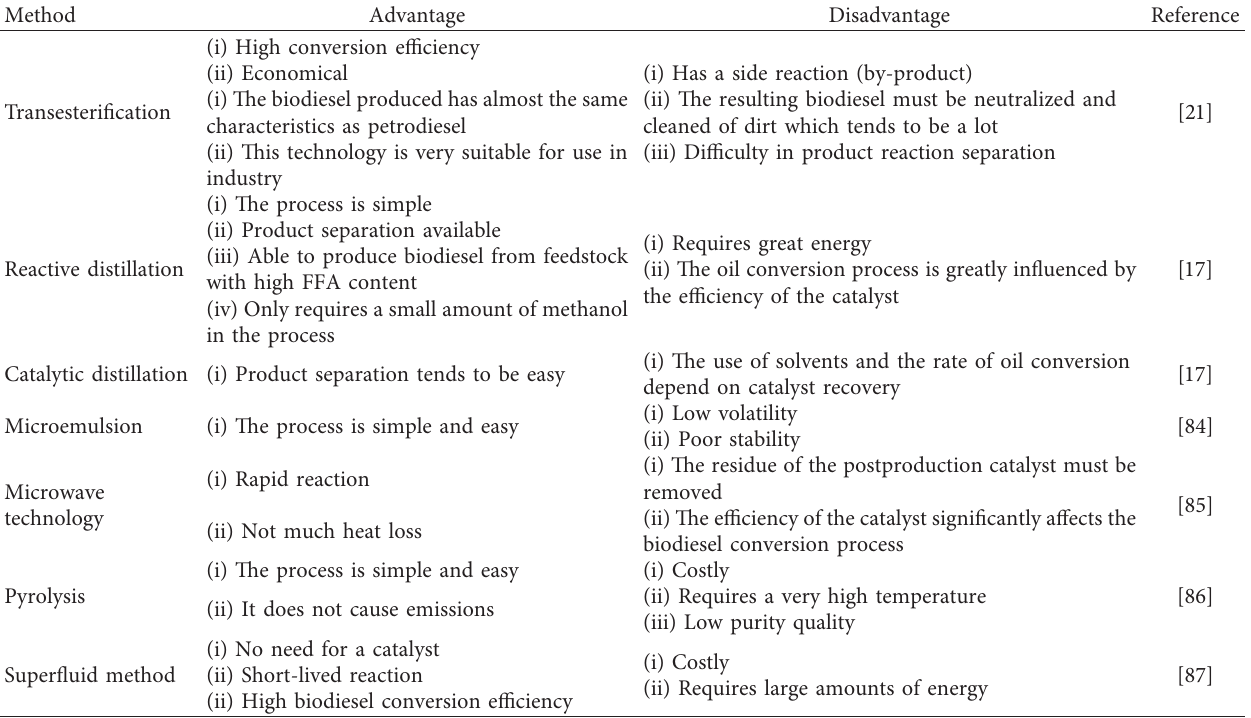
Table 3: Comparison of the various methods used in the conversion of refined oil to